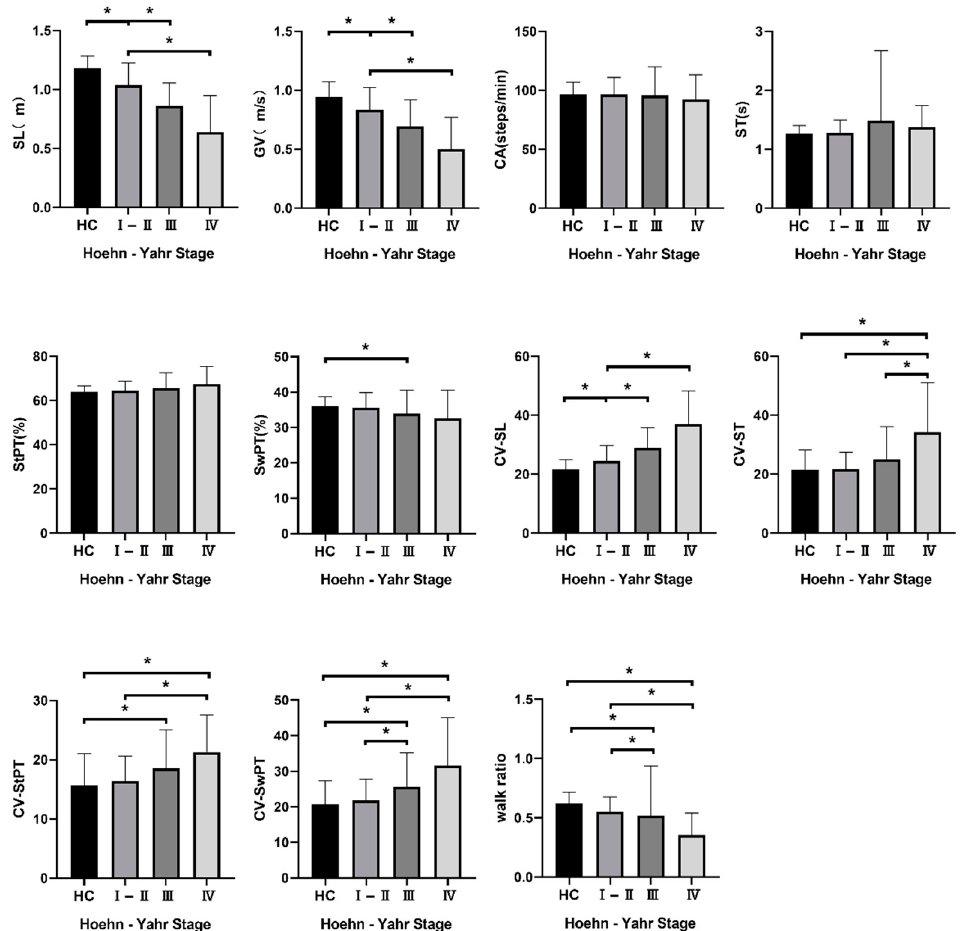
Figure 2. Spatiotemporal gait parameters of participants. Note: Value is listed as mean ± SD; * p < 0.05. Abbreviations: PD: Parkinson’s disease; HC: healthy control subjects; H–Y stage: Hoehn–Yahr stage; SL: stride length; ST: stride time; GV: gait velocity; CA: cadence; CV: coefficient of variation; StPT: stance phase time; SwPT: swing phase time.